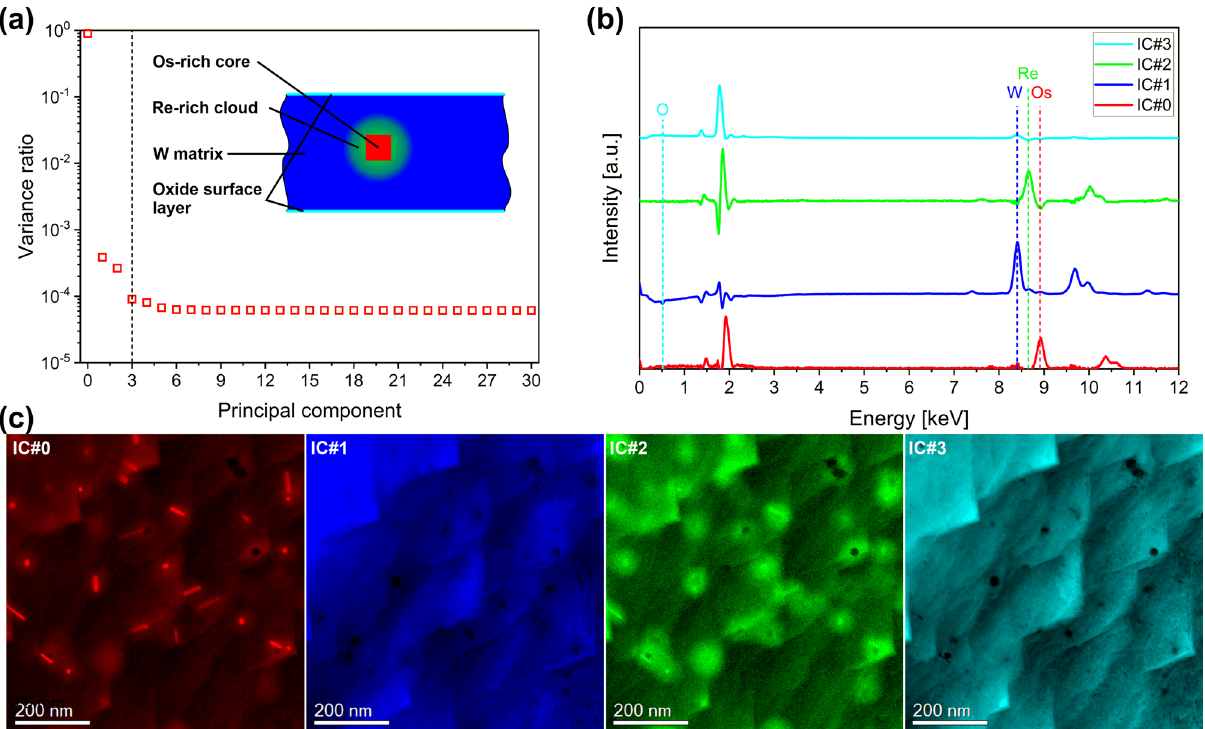
Figure 5. Results of a blind source separation (BSS) by PCA and ICA of the STEM-EDX data presented in Fig. 6. ( a ) Screen plot of the first 30 principal components (the dashed line indicates the number of independent components). The inset shows a schematic cross-sectional view of the sample for illustration purposes. ( b ) Corresponding independent component spectra. ( c ) Independent component maps showing the presence of Os-rich cores (IC#0), a W matrix (IC#1), a Re-rich cloud around the Os-rich cores (IC#2), and an oxide surface layer (IC#3), which is most probably due to the sample